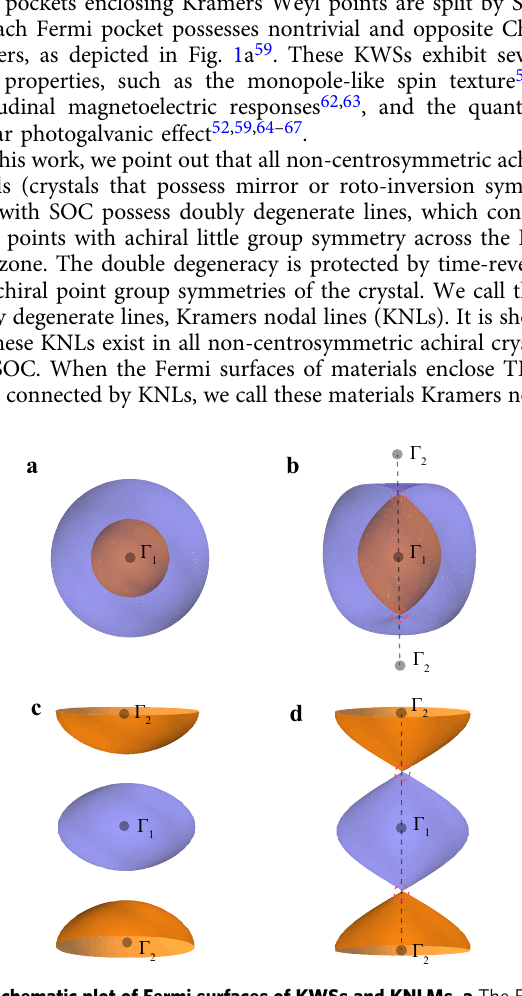
Fig. 1 Schematic plot of Fermi surfaces of KWSs and KNLMs. a The Fermi surface of a KWS where two Fermi pockets enclose one TRIM. b Spindle torus-type Fermi surface in a KNLM induced by a KNL (the dashed black line). c The Fermi surface of a KWS where each pocket encloses a different TRIM. d Octdong-type Fermi surface in KNLMs induced by a KNL. The gray dots in a – d indicate the position of TRIMs Γ 1 , Γ 2 . The touching points of the Fermi surfaces are circled by red dashed